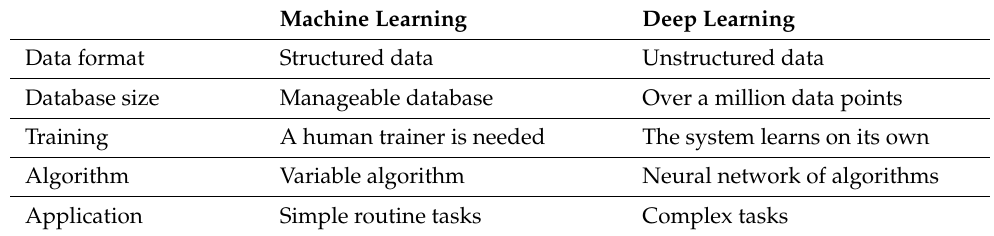
Table 4. Machine learning and deep learning main differences.